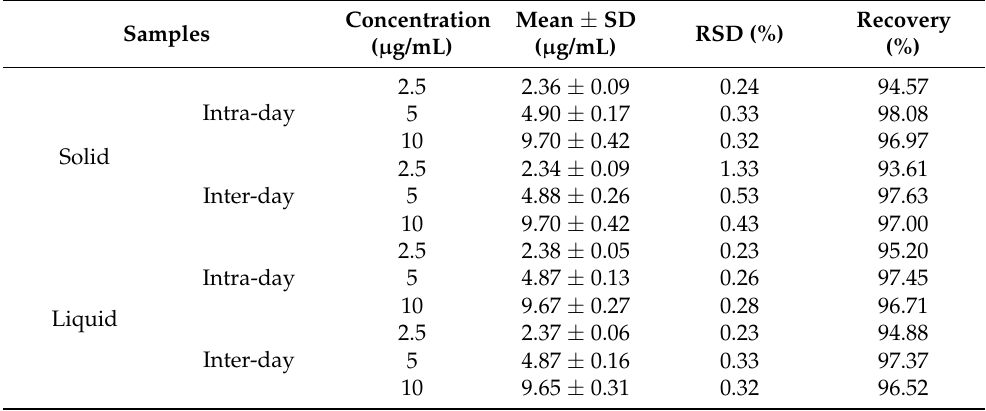
Table 4. Precision and accuracy of the analytical method for thiabendazole in the solid and liquid food samples.